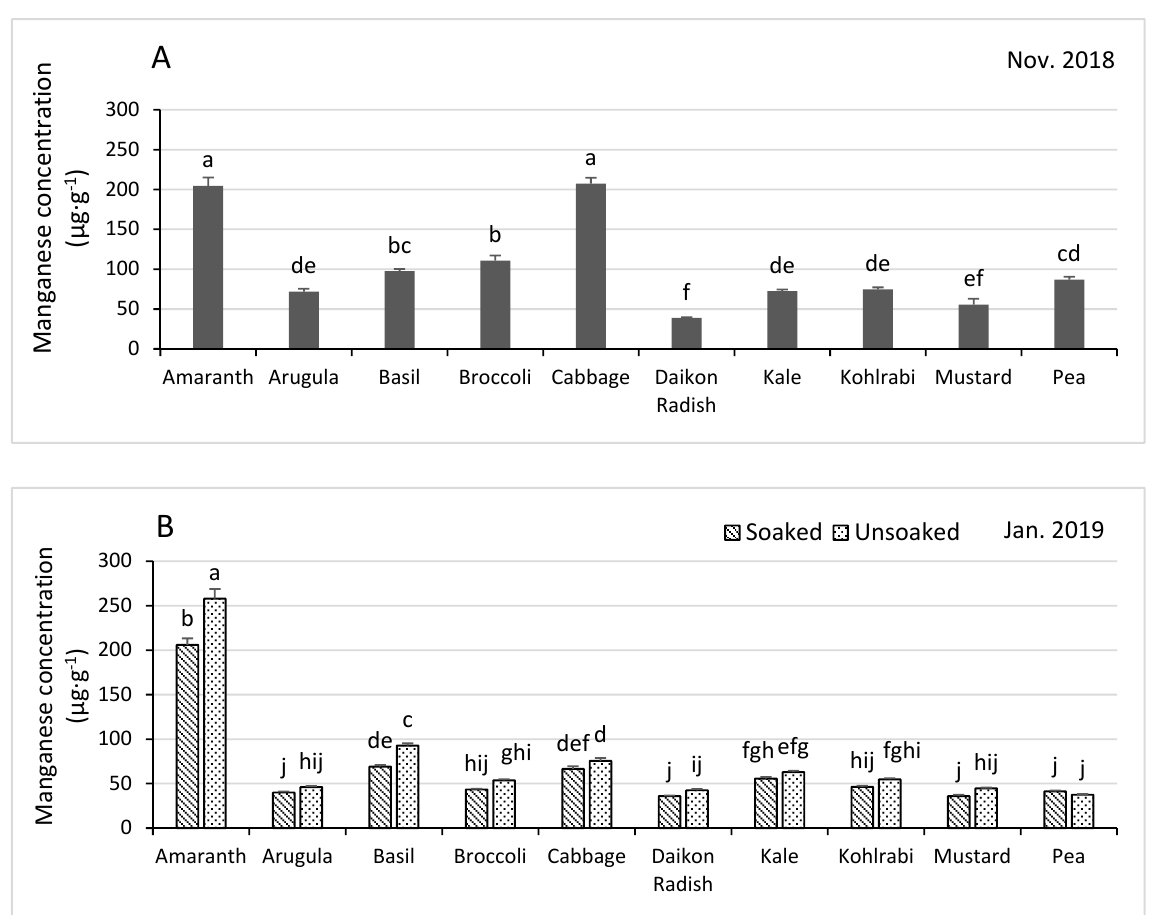
Figure 6. Manganese concentrations on a dry weight basis in ten microgreens affected by the main effect of species in November 2018 ( A ) or by the interaction between species and seed soaking in January 2019 ( B ). Means with standard error bars of each species were obtained by averaging data from both fertilization and pre-sowing seed treatments ( A ), or by averaging data from both fertilization treatments ( B ). Different lowercase letters suggested significant difference among treatments indicated by Tukey’s HSD test at α ≤ 0.05.